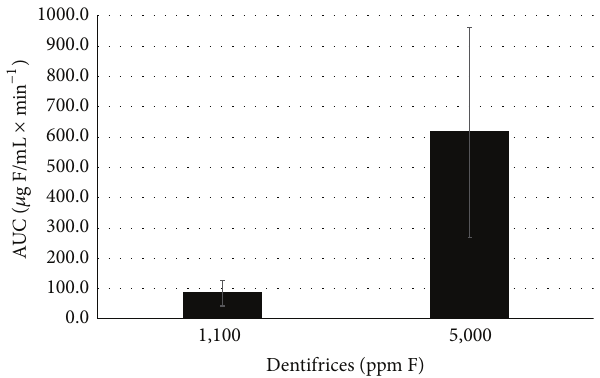
Figure 2: Mean ± SE of the area under curve (AUC) of salivary F concentration × time ( 𝜇 g F/mL × min −1 ) according to the groups tested. Groups were statistically different ( 𝑃 < 0.001